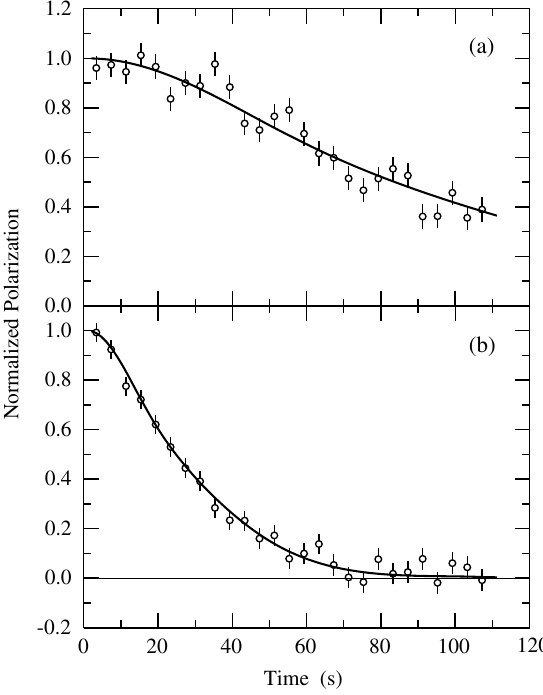
FIG. 2. (from Ref. [1]) Measurements of the IPP as a function of time after the polarization was rotated into the horizontal plane. The scale is set so that the normalized polarization is unity at t ¼ 0 s. The measurements were made with two beam polariza- tion states, separately normalized and then averaged. (Both the spin tune and the phase were constrained in order to improve the analysis accuracy for small IPP values [1].) The two panels represent two different sextupole magnet settings, resulting in polarization lifetimes, defined as the time for the normalized IPP to reach 0.606, or 64 . 7 (cid:2) 5 . 4 s and 18 . 6 (cid:2) 2 . 6 s in (a) and (b), respectively.